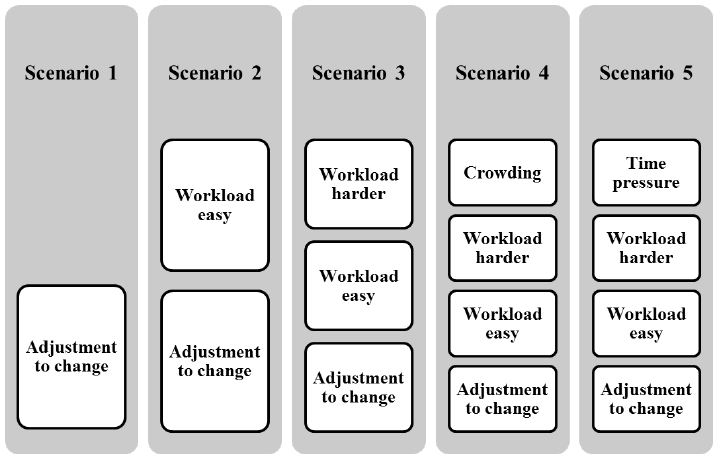
Figure 1. The mapping between scenarios and